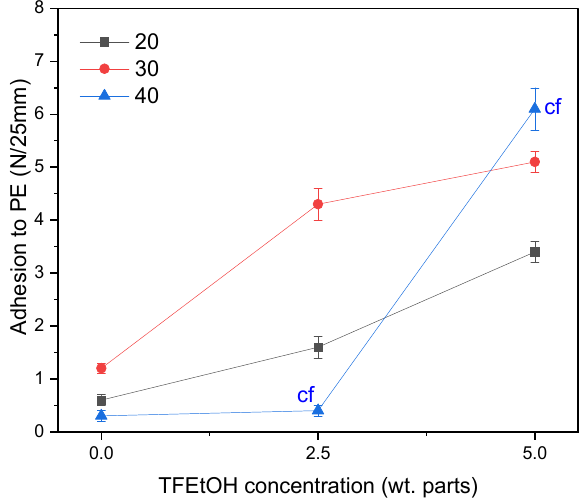
Figure 6. Adhesion to PE of PSA (with different fluorotelogen and LMA content, 2 wt. parts of aliphatic urethane acrylate/100 wt. parts of a syrup; UV dose of 8 J/cm 2 ) (cf — cohesive failure).